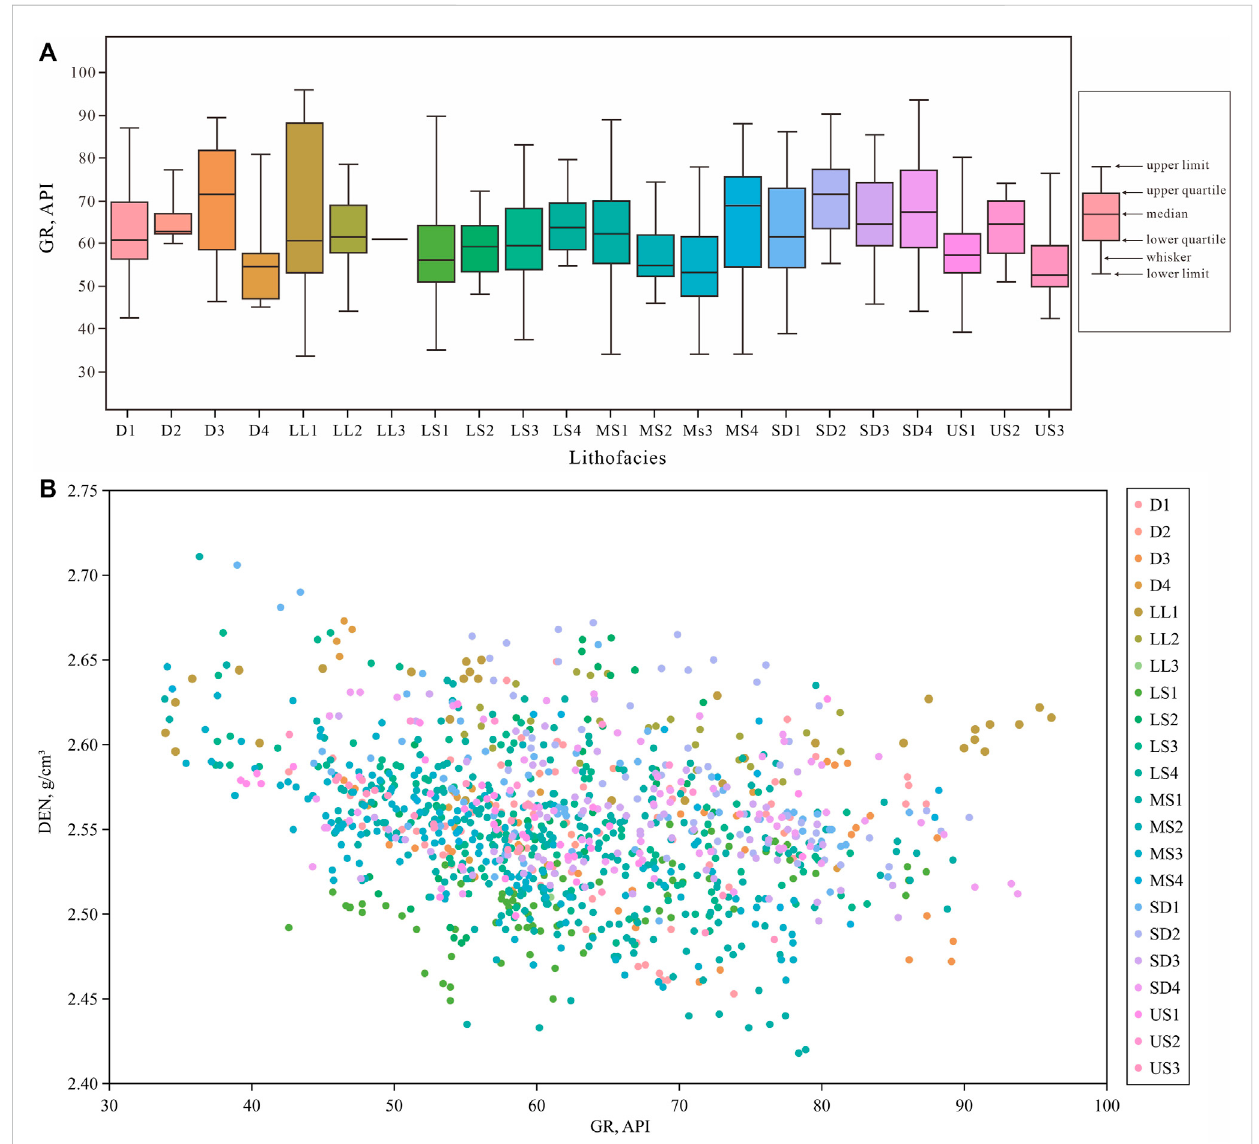
FIGURE 4 Boxplot of gamma-ray logging values for different lithofacies types (A) and cross-plot of DEN-GR (B) .